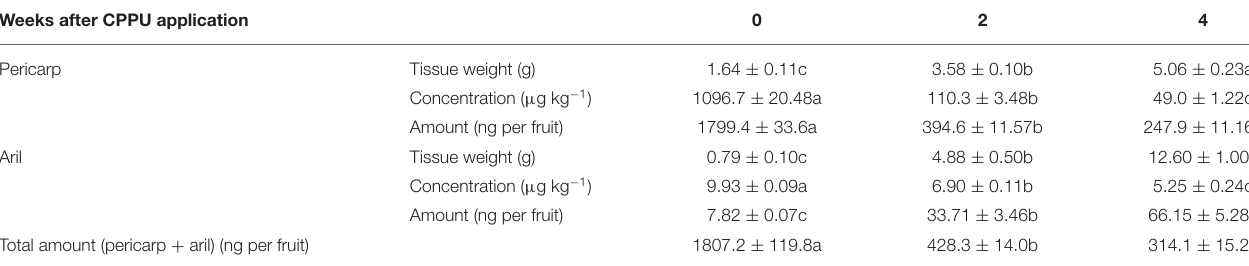
TABLE 1 | Tissue weight and CPPU residue in the pericarp and the aril at 2 and 4 weeks after CPPU application (WACA). Weeks after CPPU application